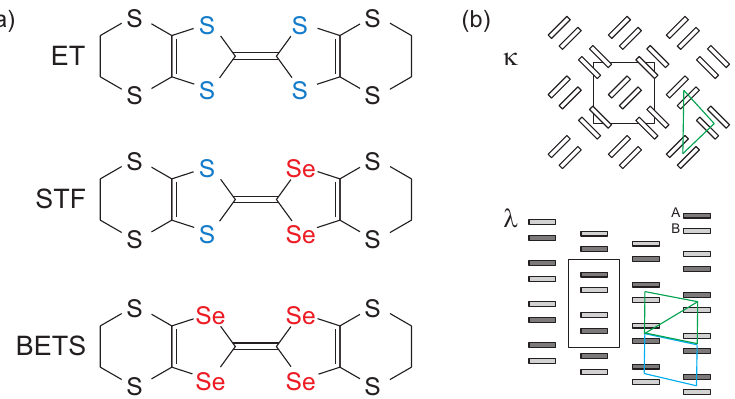
Figure 1. ( a ) The donor molecule ET = BEDT-TTF, i.e., bis-(ethylenedithio)-tetrathiafulvalene), is the most common building block, but sulfur can be replaced by selenium, leading to STF = BEDT-STF, i.e., bis-(ethylenedithio)-diseleniumdithiafulvalene, and BETS = BEDT-TSF, i.e., bis-(ethylenedithio)- tetraselenafulvalene. The more extended orbitals cause a larger bandwidth favoring better con- ductivity. ( b ) The two-dimensional charge transfer salts form different dimer patterns, where two crystallographically independent donors crystallize face-to-face. In the κ -phase the dimers are rotated with respect to each other, while the λ -pattern is organized in stacks with two dimers per unit cell; here, the constituent molecules A and B differ by symmetry. The unit cell given by black contains four molecules (A, B) and (B (cid:48) , A (cid:48) ). The triangular arrangement of the dimers is indicated in green, where—depending on the particular transfer integrals—a high degree of frustration can be reached. Due to the weaker diagonal interaction, a square tiling occurs, shown by blue